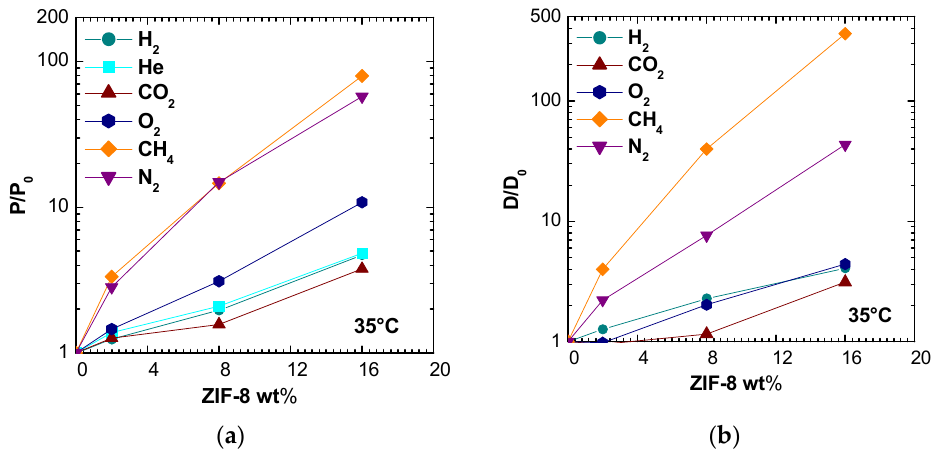
Figure 12. Relative permeability ( a ) and diffusivity ( b ) increase of various gases in PSf/ZIF-8 mixed matrix membranes as a function of ZIF-8 wt% at 35 °C. The behavior at 50 and 65 °C is reported in Figure S5. Figure 13 allows for a better correlation of permeability enhancements to diffusivity